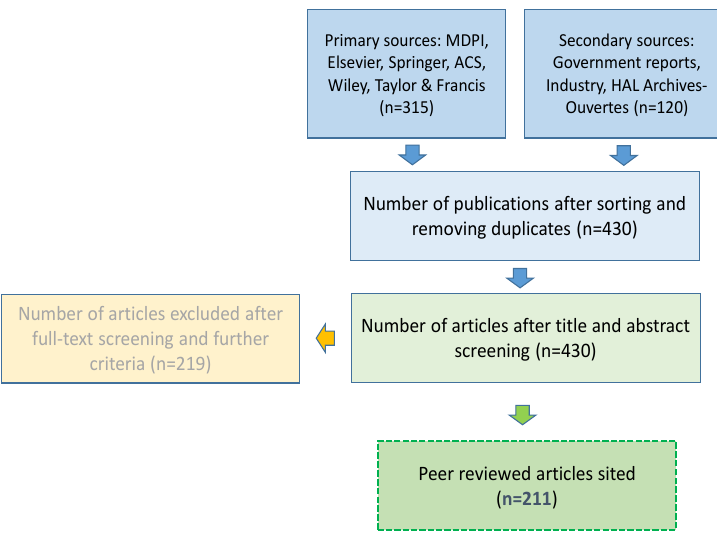
Figure 2. Diagram of the literature source selection process.